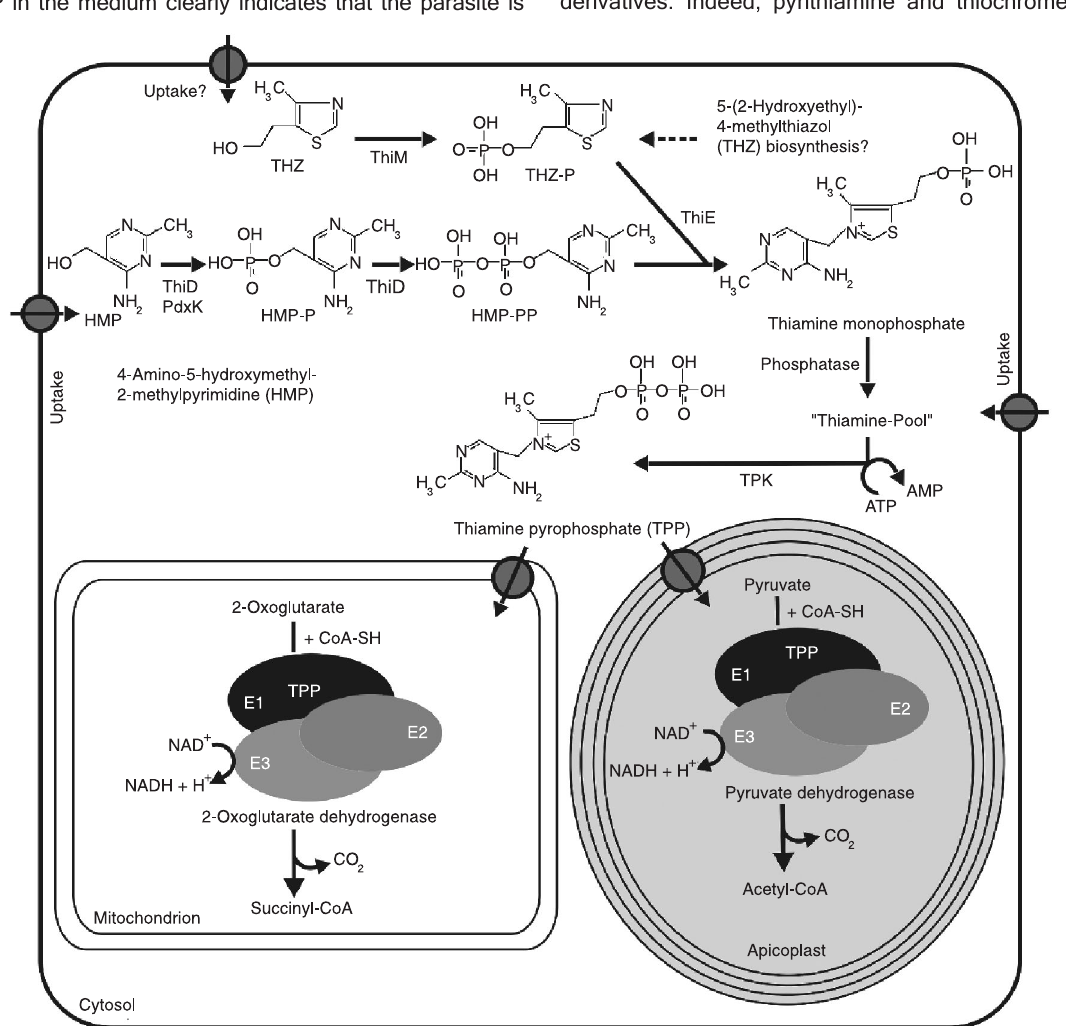
Figure 2. Generation of thiamine pyrophosphate and its trafficking within Plasmodium falciparum. Transport mechanisms are indicated by . For explanation of the abbreviations see